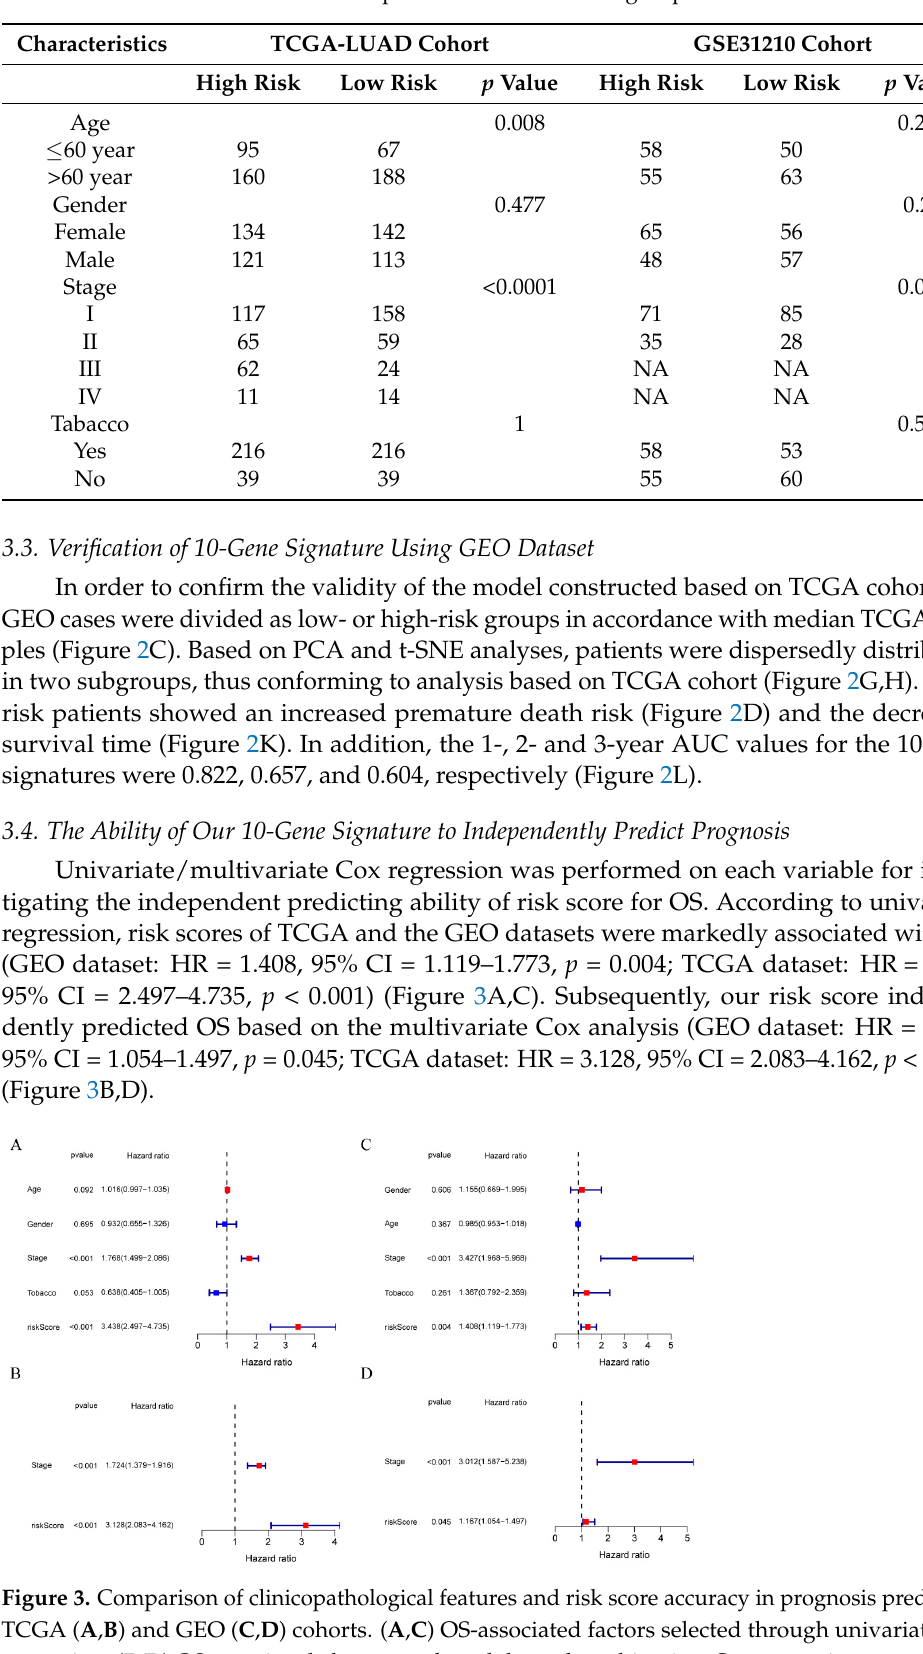
Table 2. Baseline characteristics of the patients in different risk groups.